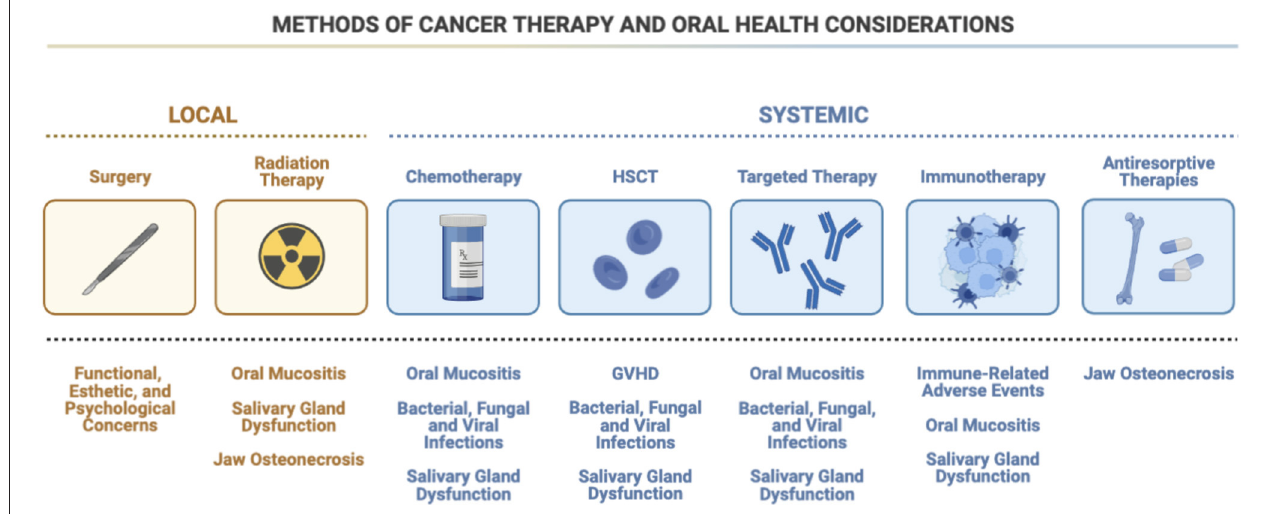
FIGURE 1 | Methods of cancer therapy and oral health considerations. There are many types of possible therapies used to treat cancer, each with their own oral health side effects. For example, chemotherapy and targeted therapy designed to treat both local and systemic cancers carry with them similar concerns for oral mucositis, infection, and salivary gland dysfunction. Antiresorptive therapies may raise the possibility of osteonecrosis, which is also a concern when radiation therapy is used, although the possibility of emergent oral mucositis and salivary gland dysfunction are less prevalent with antiresorptive therapies. HSCT, hematopoietic stem cell transplantation; GVHD, graft-vs.-host disease; HSV, herpes simplex